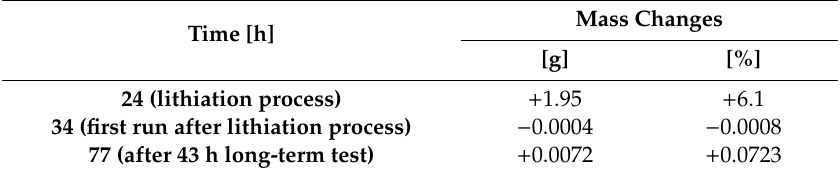
Table 6. Changes in the mass of the high-nickel Inconel 600 alloy depending on the Model III operating